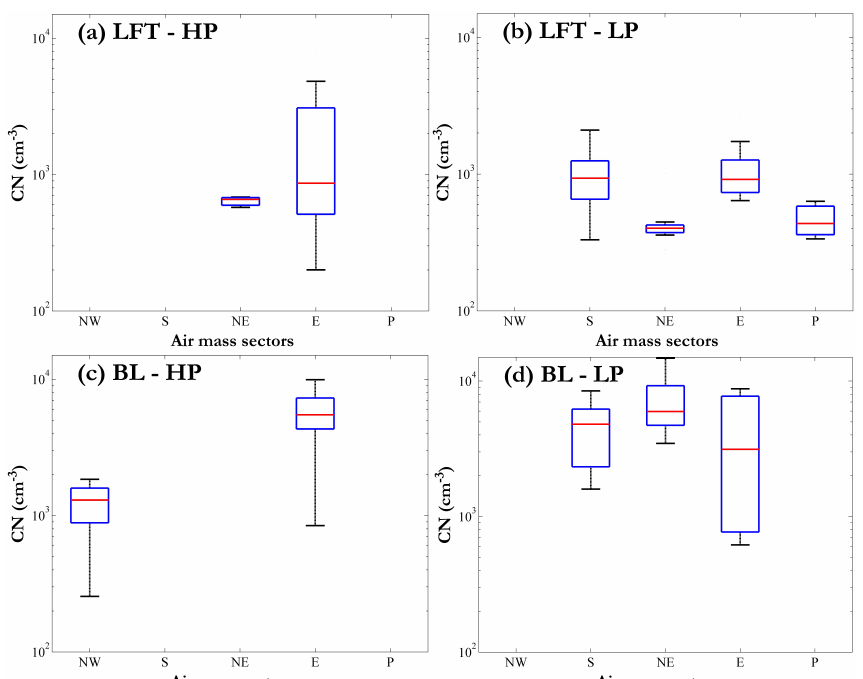
Fig. 3. Total CN concentration ( D p > 10 nm) as a function of the air mass origin (NW: north-west Europe; S: south Europe; NE: north Europe; E: east Europe; P: polar) in the lower free troposphere (FT) during anticyclonic (HP, a ) and during cyclonic (LP, b ) conditions as well as in the boundary layer (BL) during anticyclonic (HP, c ) and during cyclonic (LP, d ) conditions. Lower and upper limits of the box correspond to 25% and 75% percentiles, bottom and top whiskers the 5% and 95%. Middle bars indicate the